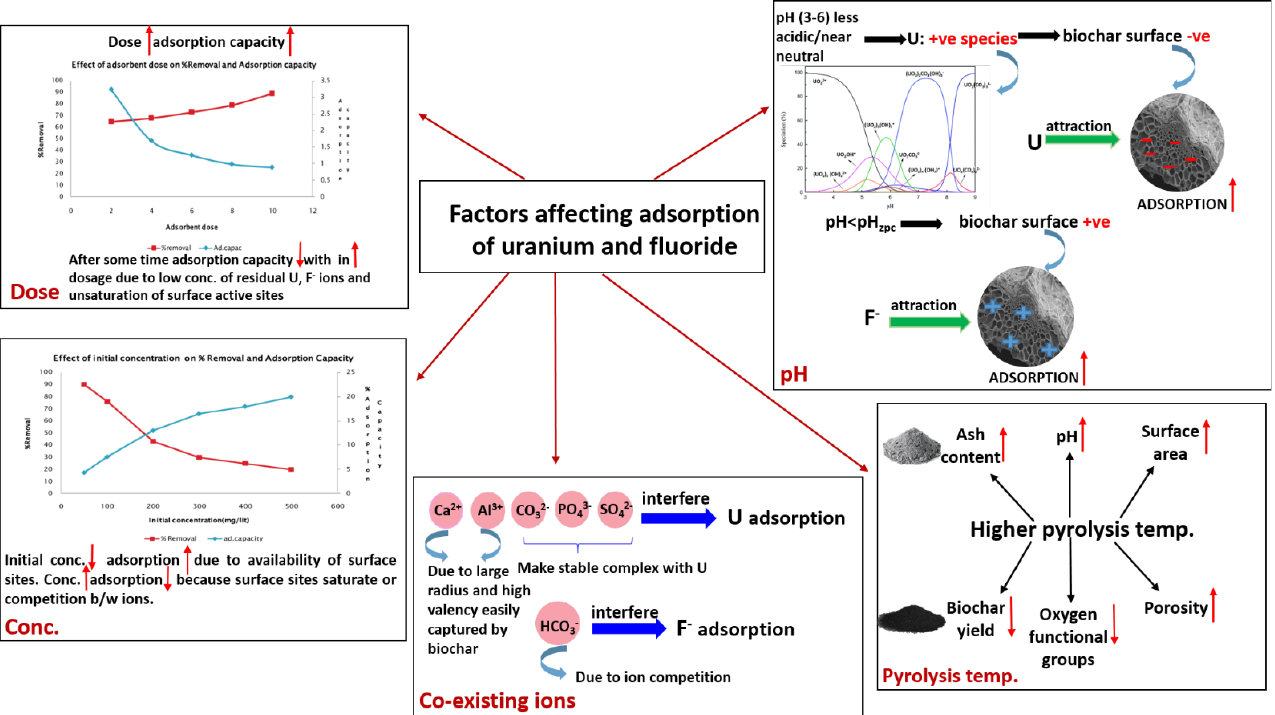
Figure 4. Effect of different parameters on the adsorption capacity and removal efficiency of U and F − , including biochar dose, initial concentration of U and F − , solution pH, pyrolysis temperature, and Co-existing ions.